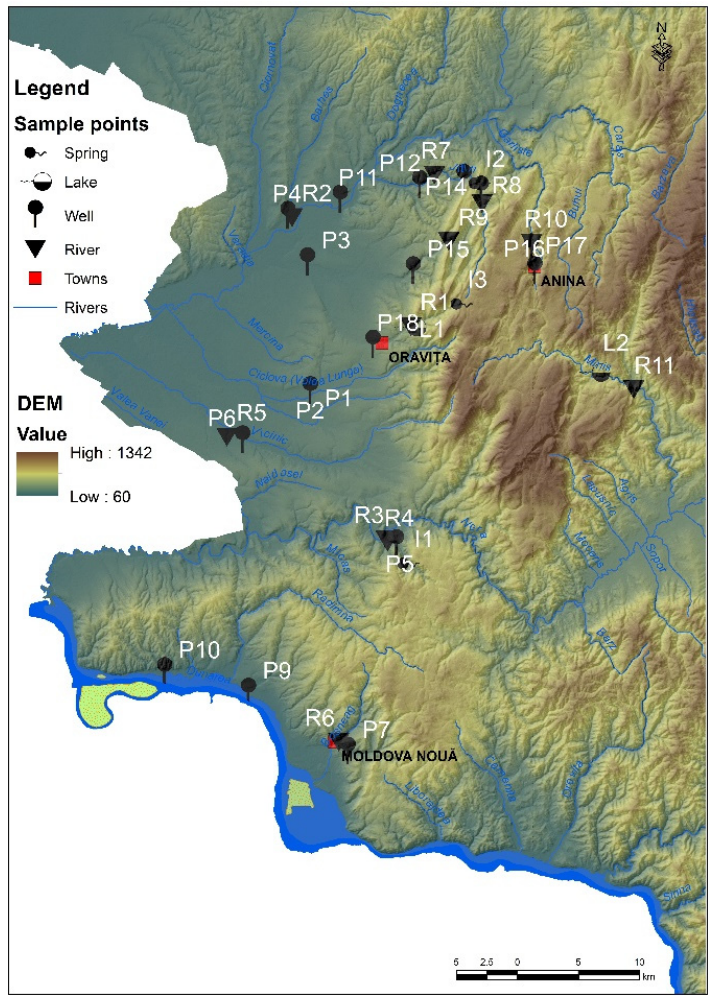
Figure 1. The southern area of the Banat Mountains, Romania (former mining area).